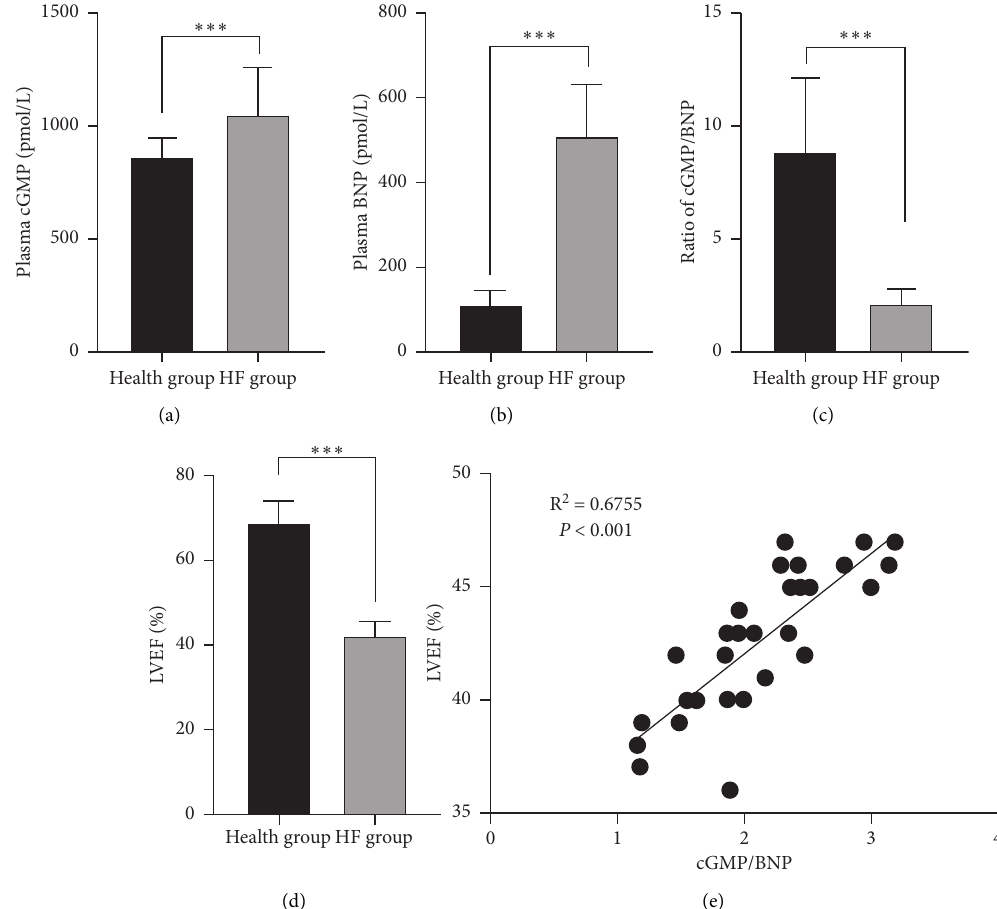
Figure 1: BNP resistance occurred in HF patients. (a) and (b) Plasma concentrations of cGMP and BNP. (c) The cGMP/BNP ratio. (d) Representative echocardiographic findings. (e) Representative correlation between LVEF and cGMP/BNP. BNP: brain natriuretic peptide; LVEF: left ventricular ejection fraction; cGMP: cyclic guanosine monophosphate; ∗∗∗ p < 0 . 001 by Student’s